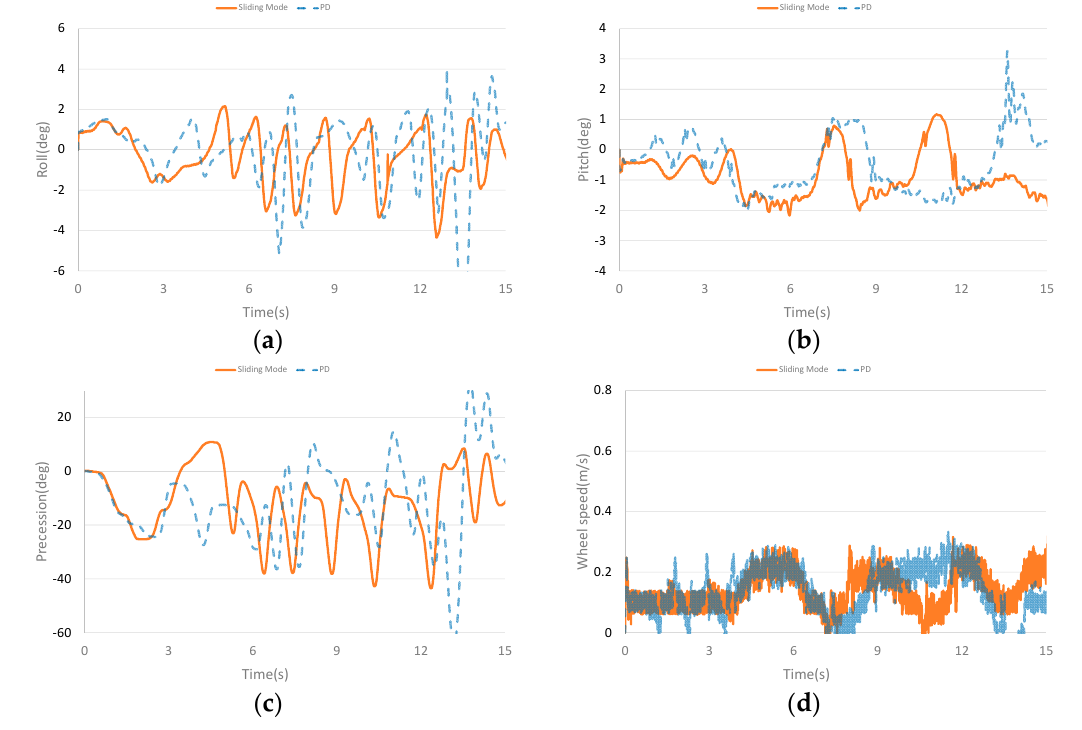
Figure 11. Curves of stochastic pulse interference experiment. ( a ) The roll angle curve of stochastic pulse interference experiment. ( b ) The pitch angle curve of stochastic pulse interference experiment. ( c ) The precession angle curve of stochastic pulse interference experiment. ( d ) The speed curve of stochastic pulse interference experiment.